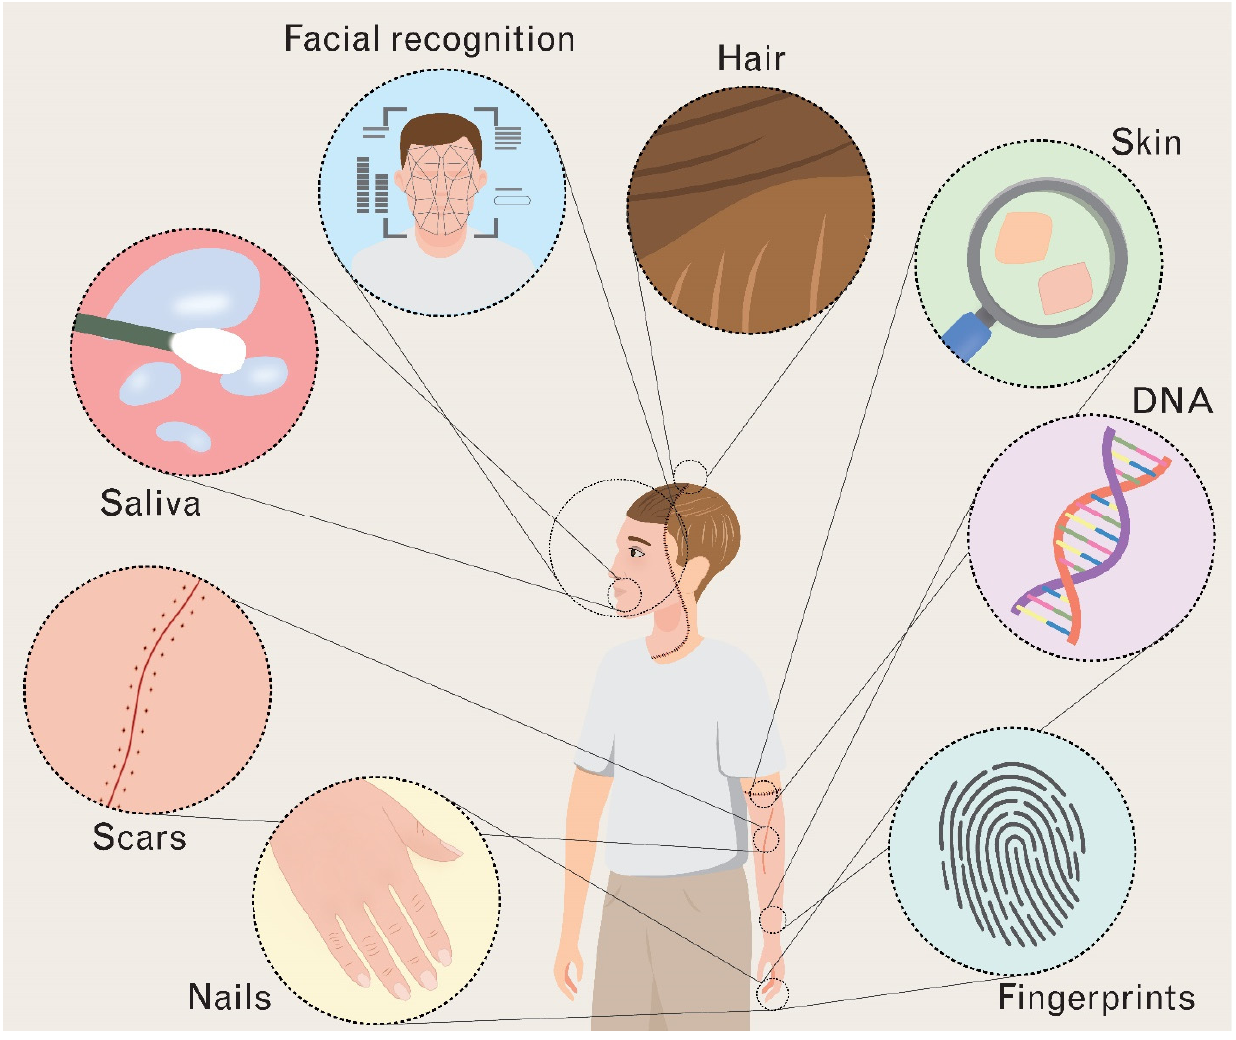
Figure 1. The face and hand transplantation recipient as a potential challenge for forensic method- ology.